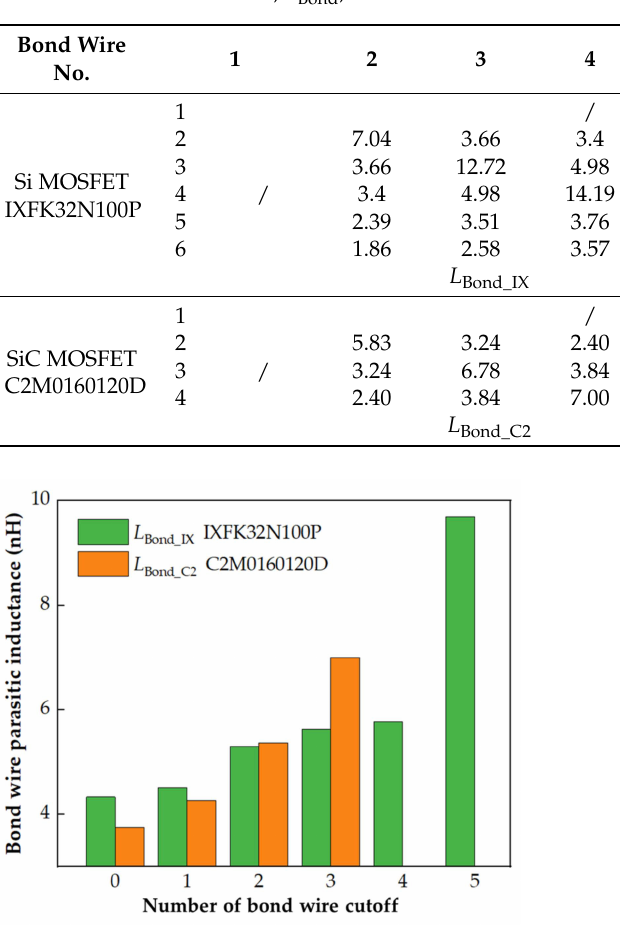
Figure 10. Parasitic inductance with different cutoff numbers of bond